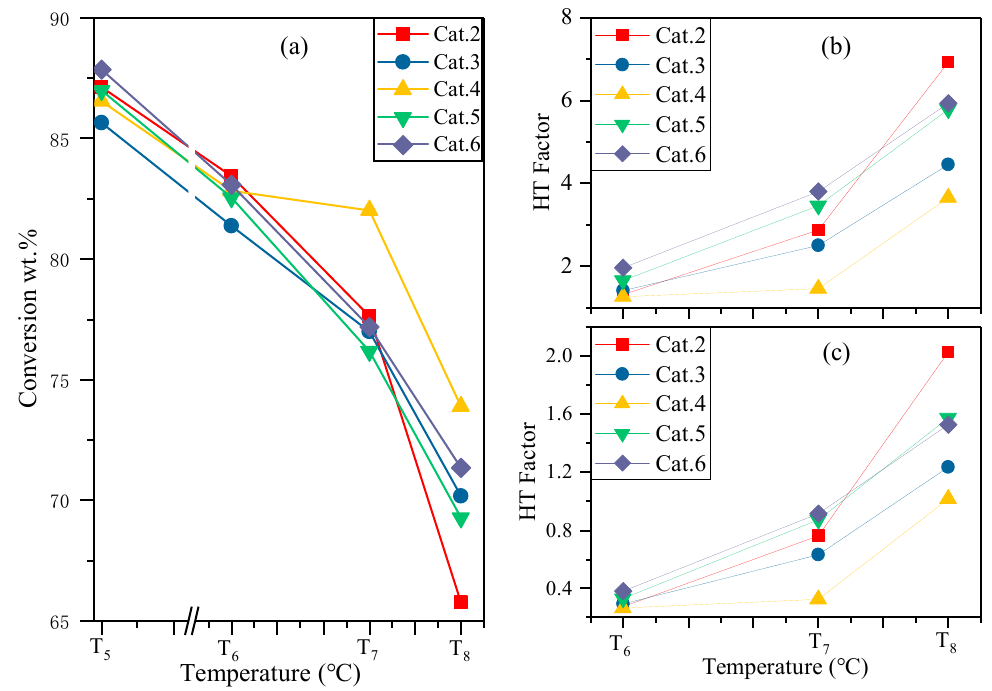
Figure 3. Catalytic activity and hydrothermal (HT) factor for compounded FCC catalysts treated by the modified series hydrothermal conditions: ( a ) conversion, ( b ) HT factors based on the recommended base catalyst, ( c ) HT factors based on Cat.2.